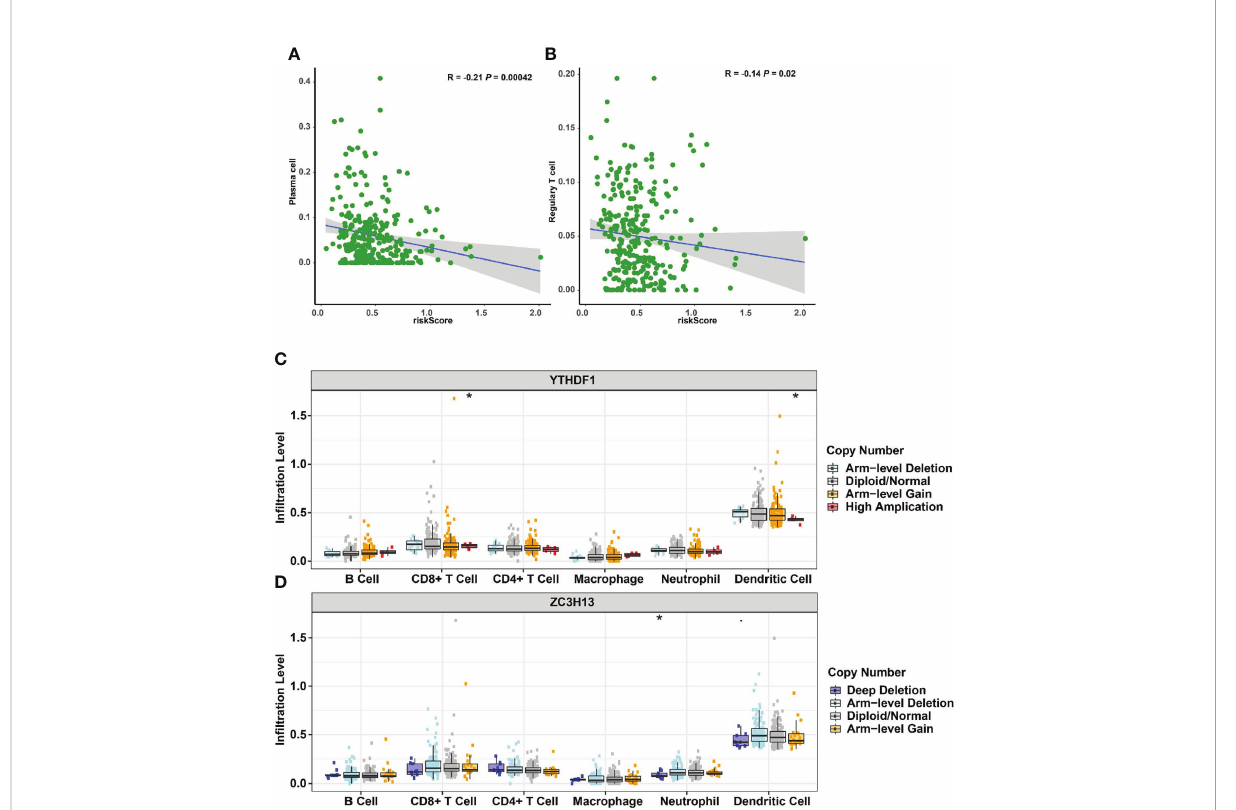
FIGURE 10 Relationships between the riskscore and in fi ltration abundances of nine immune cell types. (A) Plasma cells. (B) Regulatory T cells. Effect of the genetic alterations of m6A regulator-relevant signature on the immune cell in fi ltration. (C) YTHDF1. (D) ZC3H13. * p <